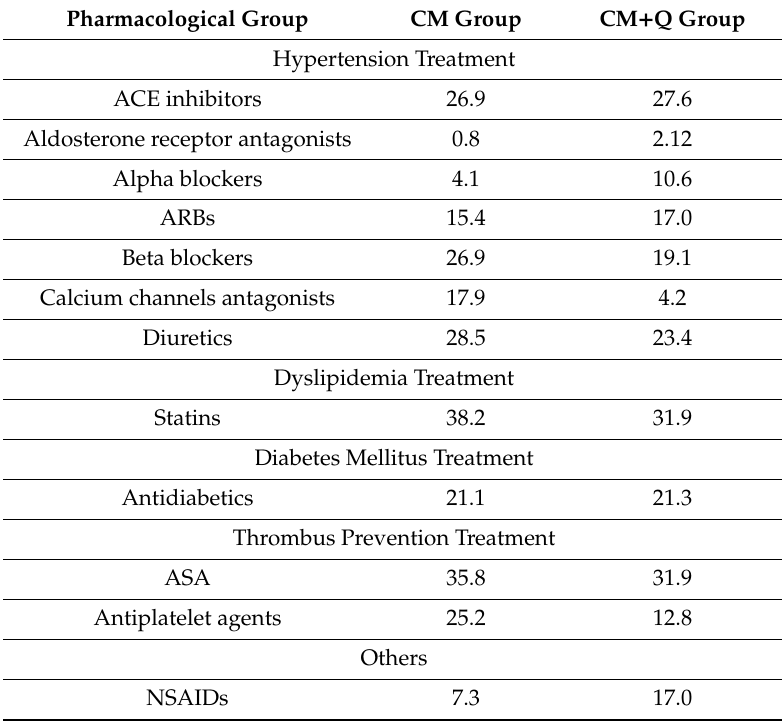
Table 2. Drug consumption before contrast media administration. ACE, angiotensin-converting enzyme; ARBs, angiotensin II receptor blockers; ASA, acetyl salicylic acid; NSAIDs, non-steroidal anti-inflammatory drugs. Data are expressed as percentage of patients. No statistical di ff erences were observed between the groups.